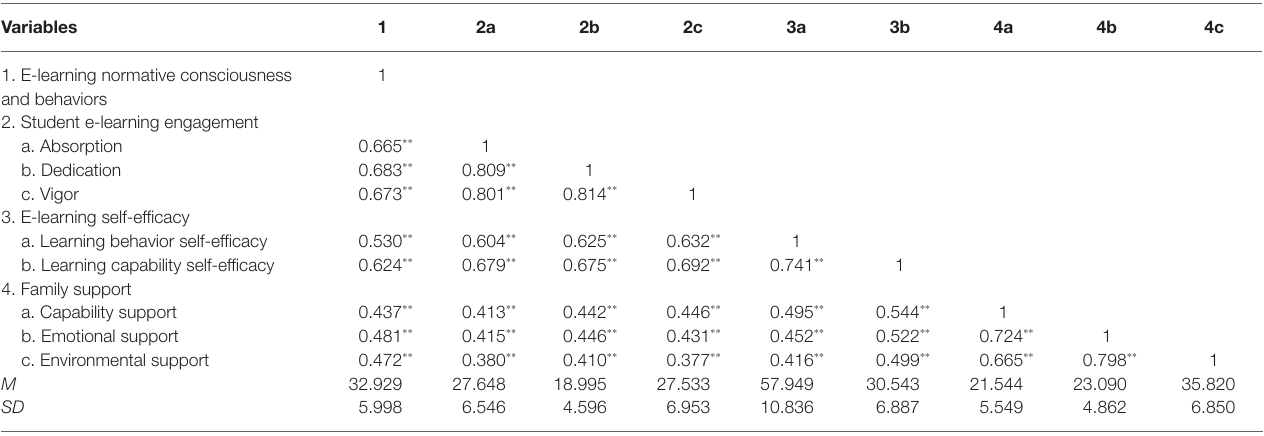
TABLE 2 | Pearson correlations among study variables. Variables